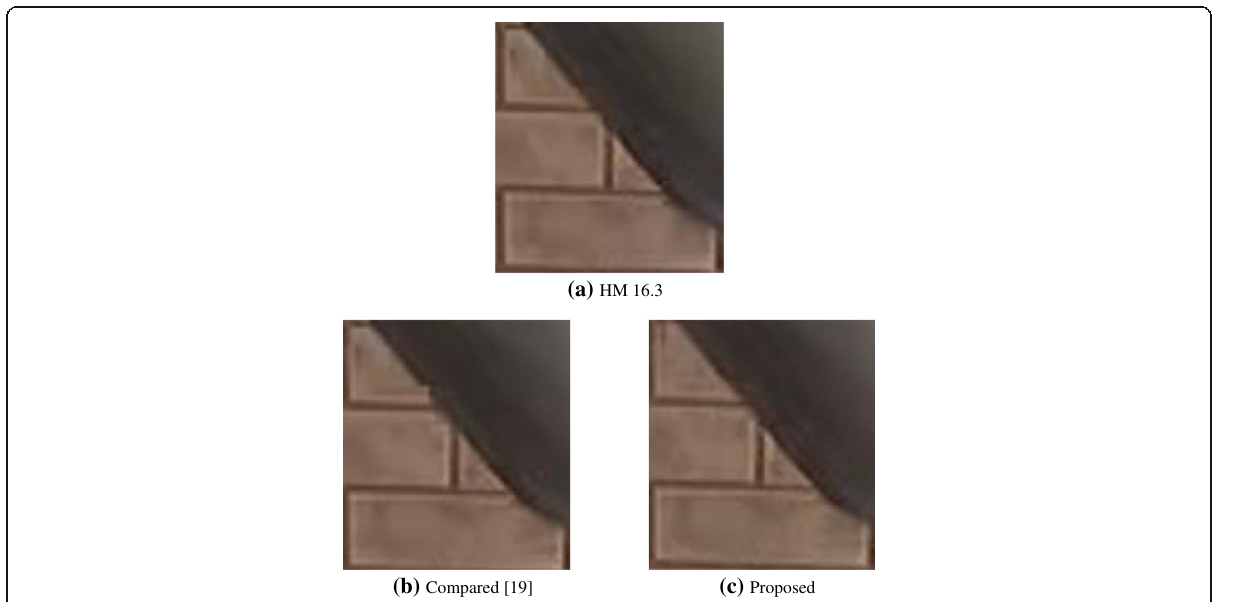
Fig. 18 Partial enlargements of the subjective comparison in the red circled region of Fig. 17. ( a ) HM 16.3. ( b ) Compared [19]. ( c ) Proposed